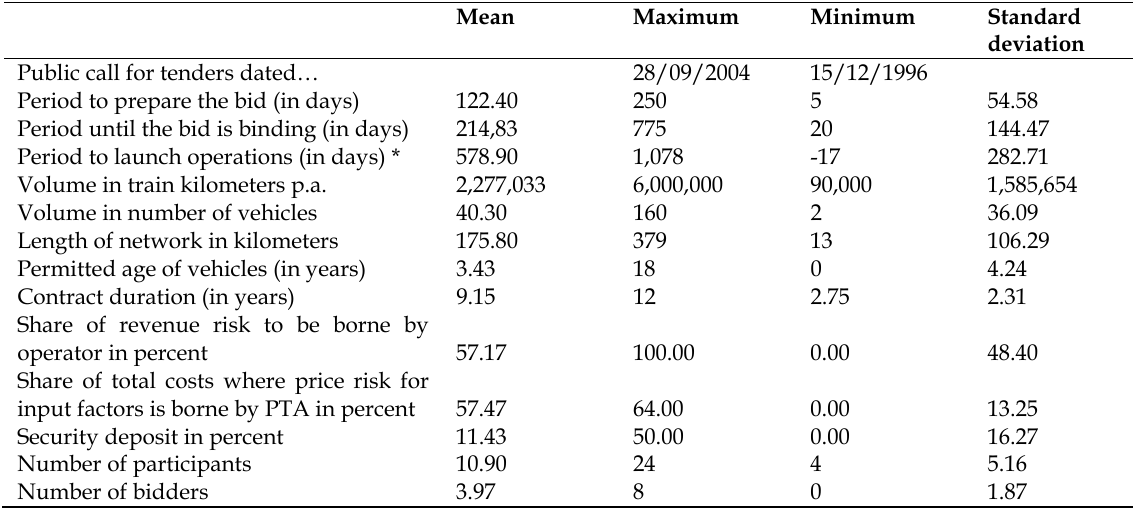
Table 1. Descriptive statistics for selected criteria Mean Maximum Minimum Standard